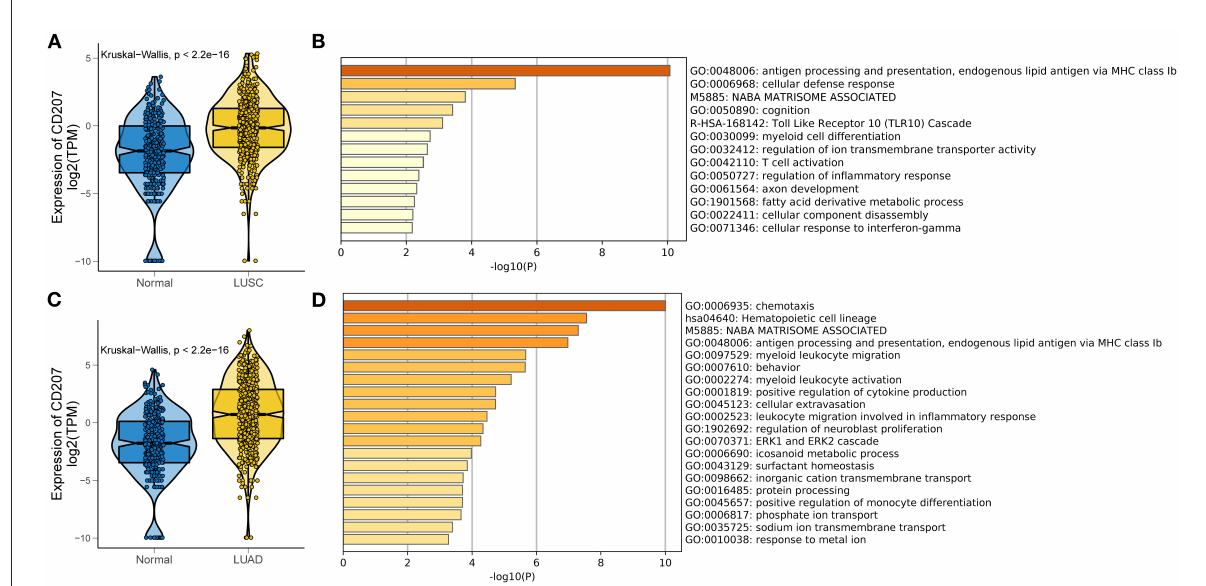
FIGURE1 Expression and functional annotation of langerin in LUSC and LUAD in the TCGA RNA-seq datasets. (A,C) Boxplots visualizing significantly different expressions of langerin between normal and LUSC (and LUAD) tissues in TCGA database. (B,D) Bar plot showing the top 20 terms derived from the gene set enrichment of the differentially expressed genes in TCGA-LUSC (and LUAD) samples. The x-axis represents statistical significance.